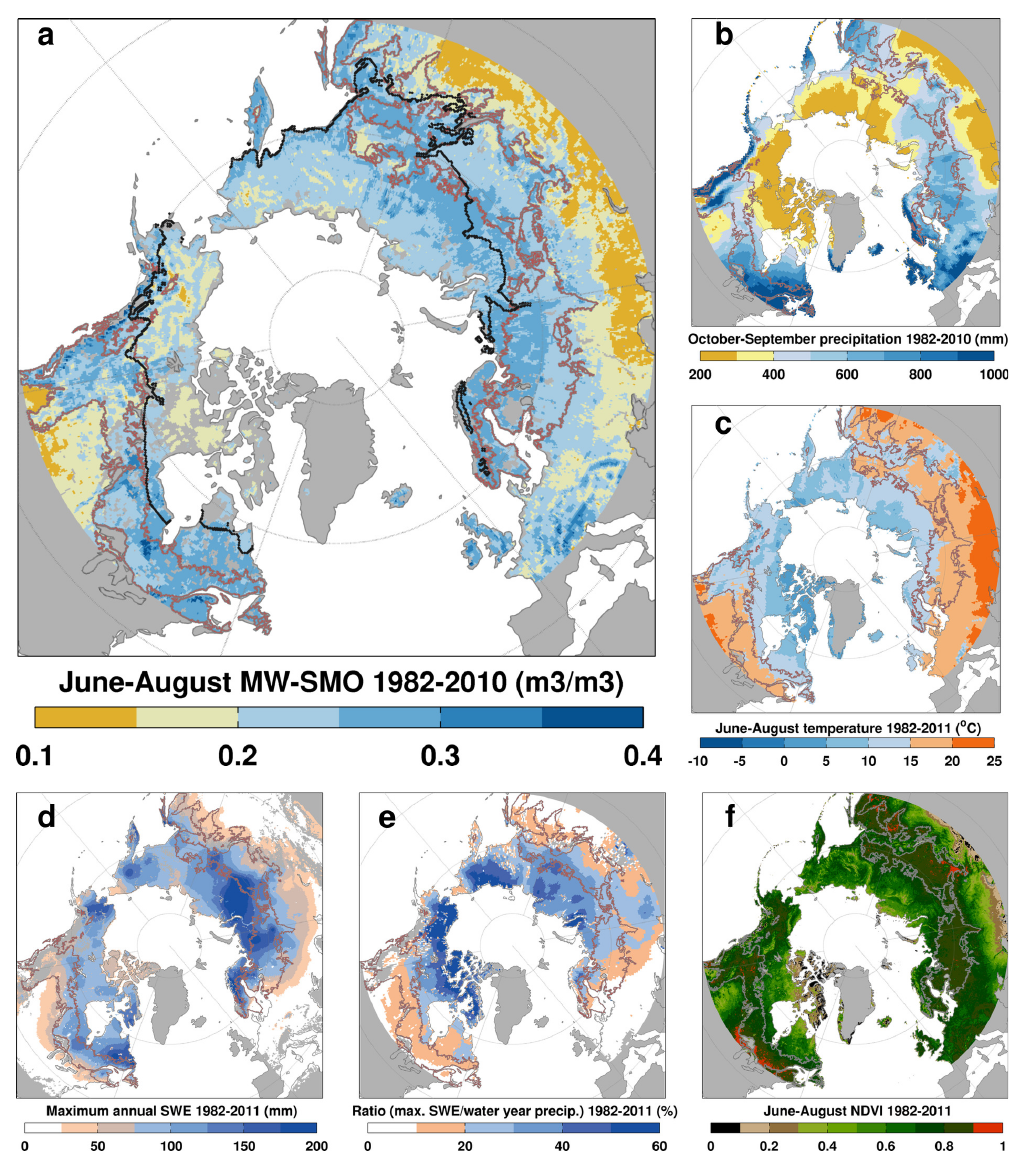
Figure A1. Extent of the boreal forest biome and climatologies of soil moisture, NDVI and primary climate variables since 1982. ( a ) summer satellite microwave soil moisture (MW-SMO, m 3 /m 3 ) with an overlay of the southern edge of the continuous permafrost (black line); ( b ) water year (October–September) precipitation from the GPCC dataset v6 (mm); ( c ) summer mean air temperature from the CRUTS 3.20 dataset (m ◦ C); ( d ) maximum annual Snow Water Equivalent from the GlobSnow product version 1.3 (mm); ( e ) ratio between maximum annual Snow Water Equivalent and water year precipitation; and ( f ) mean summer NDVI (with non-vegetated areas (NDVI < 0.1) shown in black). The areas north and south of the boreal forest (outlined in gray) correspond to the Arctic and northern temperate regions, respectively. Note that the climatology of the MW-SMO is based on the GLDAS Noah land surface model and is therefore only illustrative of the spatial patterns rather than the absolute